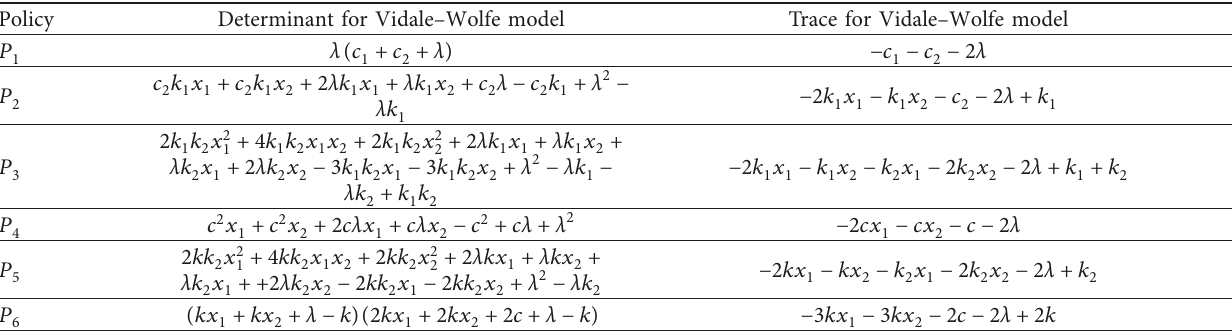
Table 4: Expressions for determinants and traces in Vidale–Wolfe model (8) under special cases of affine feedback advertising policy. Policy